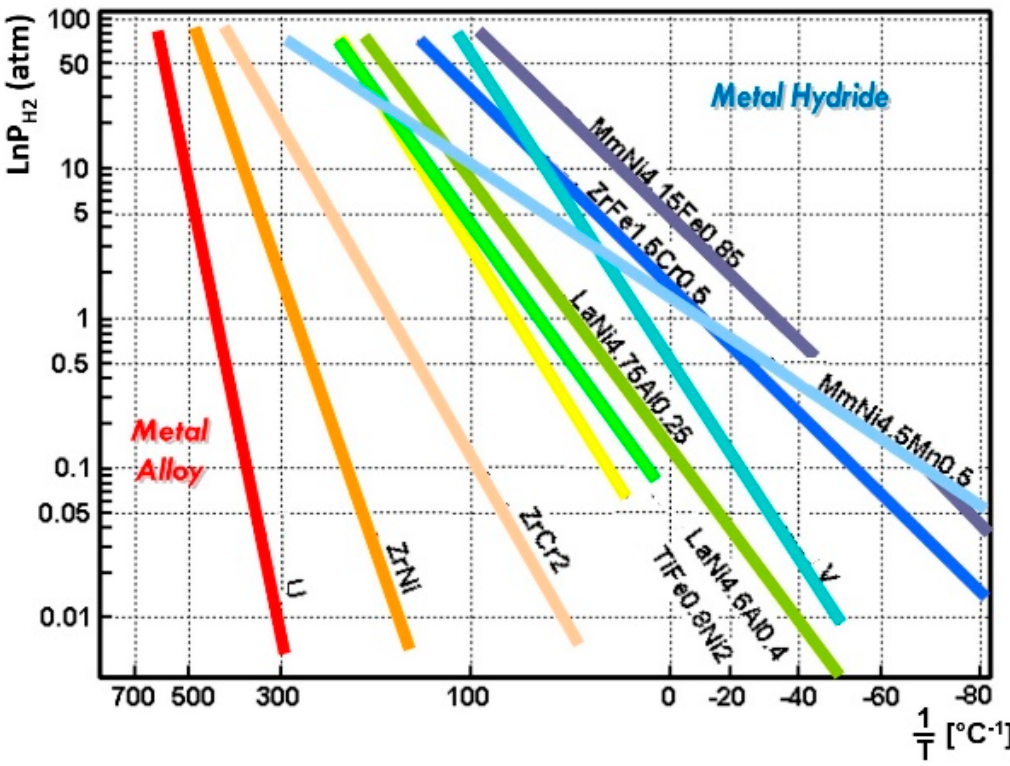
Figure 1. Metal hydride materials with their equilibrium temperature and pressure on the van’t Hoff plot demonstrates a wide range of temperature selections for an application of the metal hydride thermal energy conversion system.